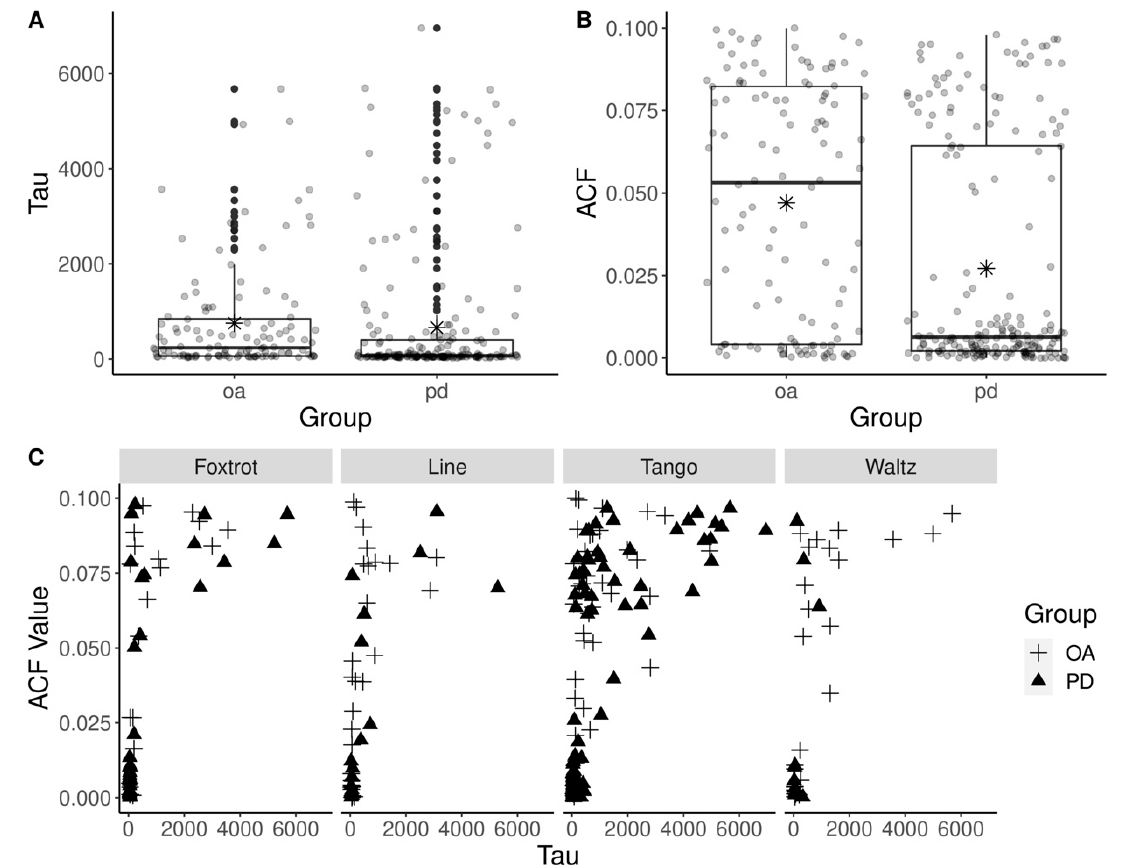
Figure 4. Delay numbers used for ApEn calculation ( A ). ACF closest to 0 at the smallest lag value (tau) ( B ). Tau values at each dance category ( C ). Datapoints include tau values for hip and knee movements. Distribution of delay numbers (OA 753.72 +/ − 1130.05; PD 660.49 +/ − 1373.47) used for ApEn calculation ( A ) and their correspondent autocorrelation functions (OA 0.047 +/ − 0.036; PD 0.027 +/ − 0.035) ( B ). Delay numbers were calculated by limiting ACF to < 0.1 coupled with 100 Hz sampling explains the large values for lag. Asterisk (*) represents the mean. C presents tau values per dance and group where one data point is one recording. These were used to calculate ApEn for each recording. No significant difference in tau values were found between PD and OA ( p = 0.89) or between dance groups ( p =